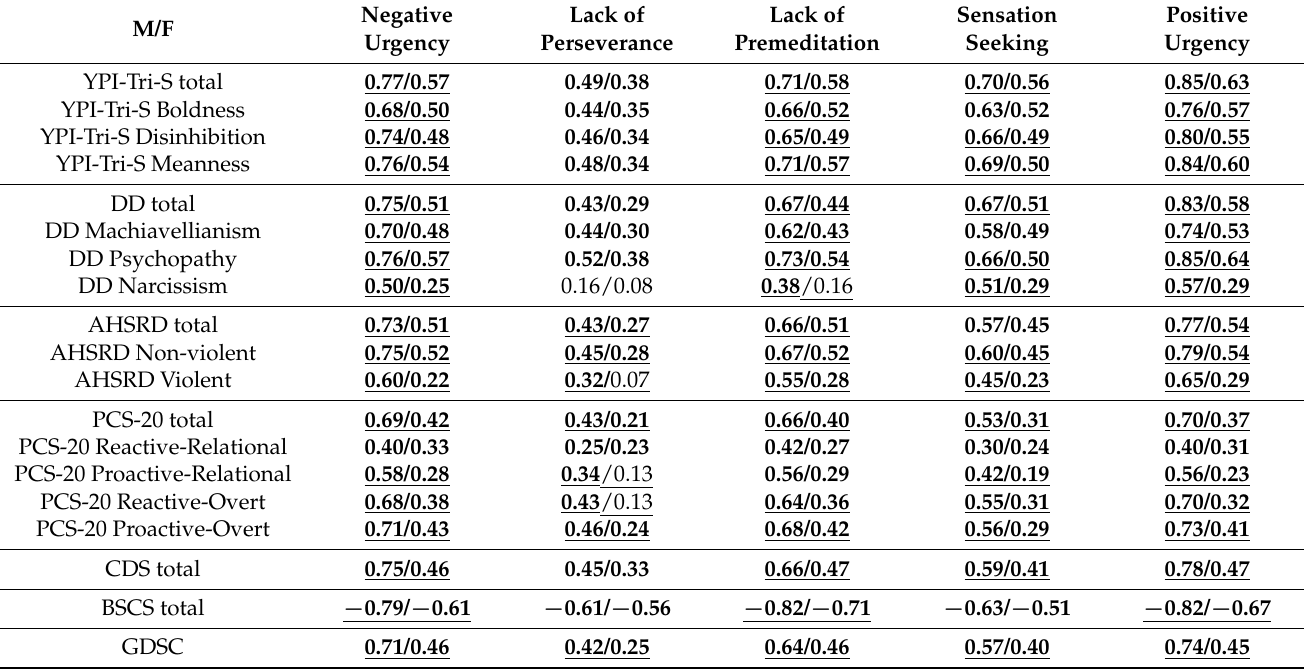
Table 6. Convergent, discriminant and criterion validity of the